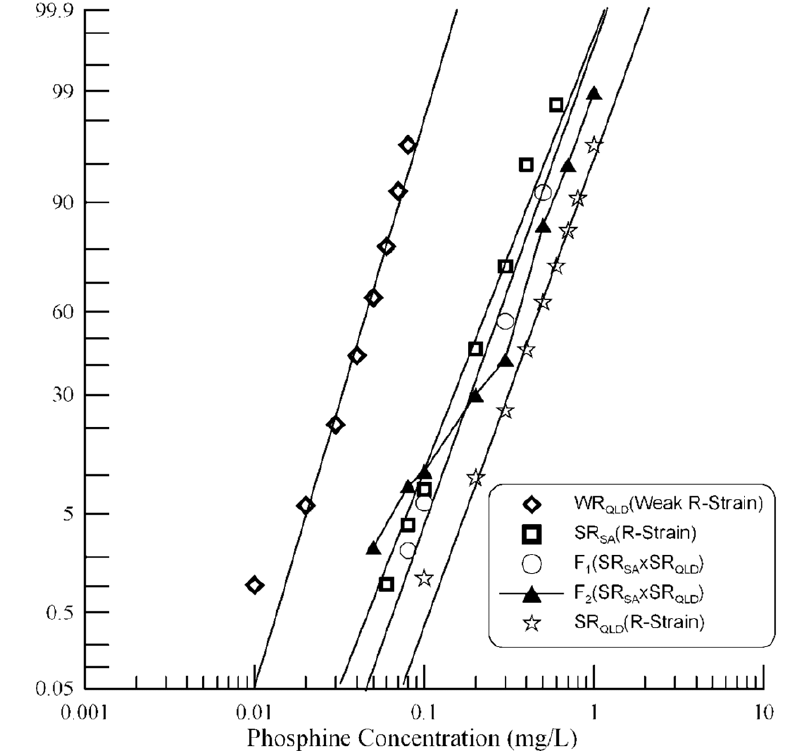
Figure 4. Resistance response of F 1 hybrids and F 2 progeny of a cross between strongly resistant R.dominica strains from South Australia and Queensland. Results are presented as log-dose mortality of the F 1 hybrids and the F 2 progeny with reference curves of the parental strains, SR SA and SR QLD , and the weakly resistant strain from Queensland (WR QLD ). Phosphine exposure was for 48 hours at 25 u C and 70% r.h.